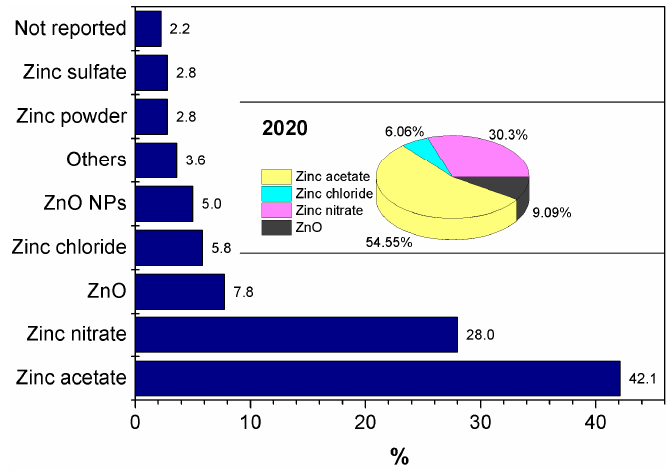
Figure 12. Zinc precursors used in the ZnO–graphene composites.